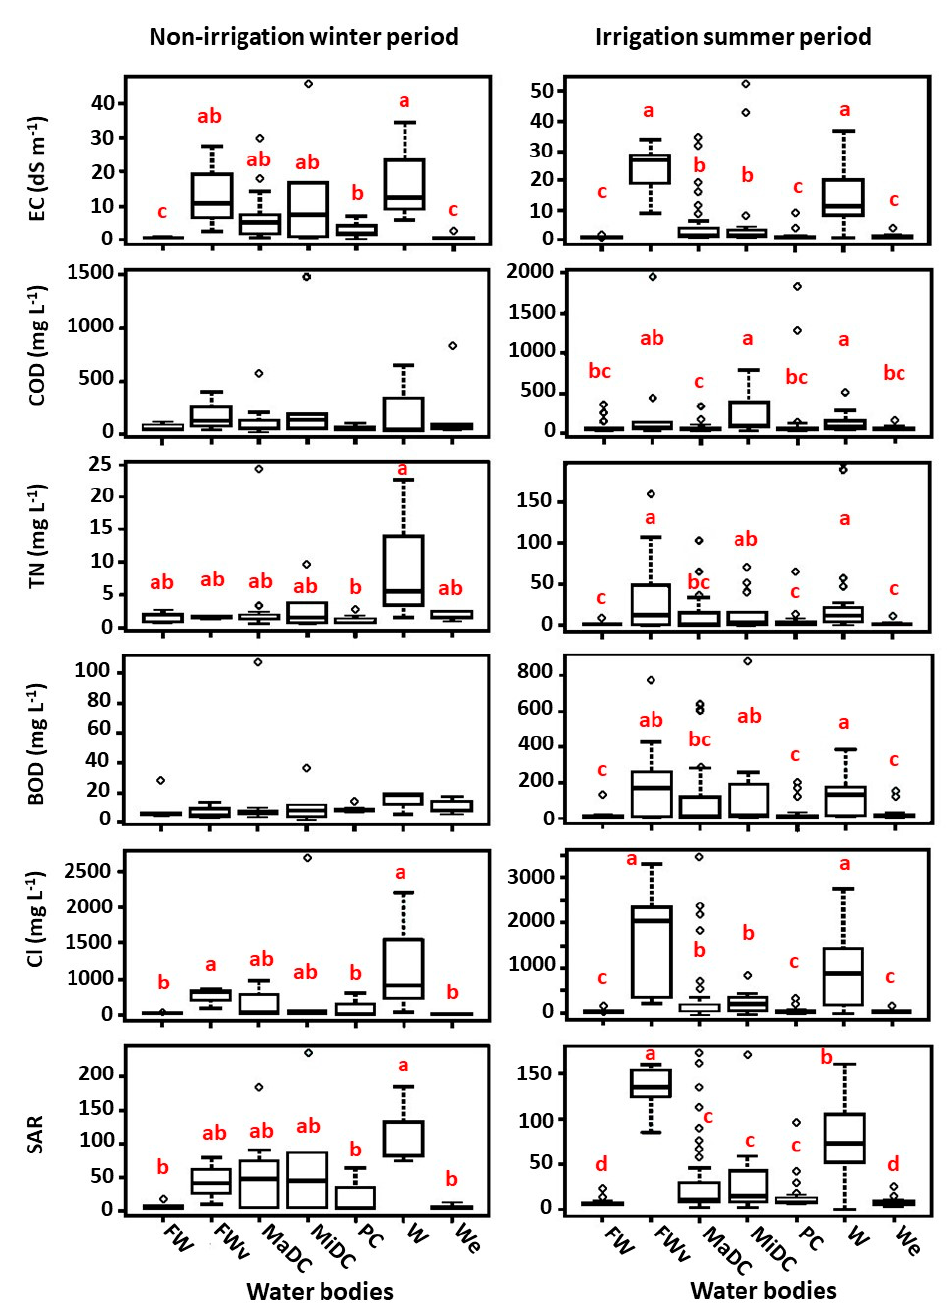
Figure 4. Electrical conductivity (EC), chemical oxygen demand (COD), total N content (TN), biological oxygen demand (BOD), Cl content (Cl), and sodium absorption ratio (SAR) in water samples collected in the non-irrigation winter period and irrigation summer period from upstream and downstream stations on the Reno river, Lamone river and Right Reno river canal (FW and FWv, respectively), drainage canal (MaDC), drainage and irrigation canal (MiDC), drainage and irrigation canal (PC), wetland landlocked inside the agricultural land (W), and well at 3 m depth (WE). Different letters indicate significant differences ( p < 0.05). In order to better show the differences for each parameter among the water bodies, a different y-axis scale was used for the non-irrigation winter period and for the irrigation summer period.